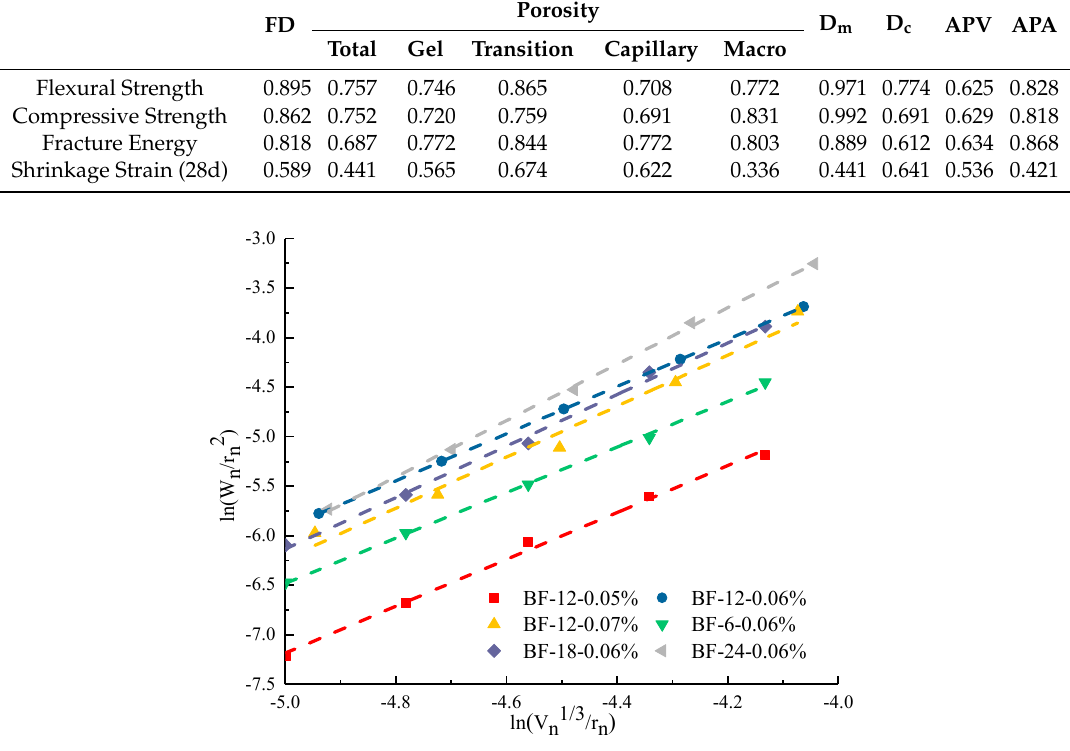
Figure 17. Results of D t at diameter ranges 20–50 nm.